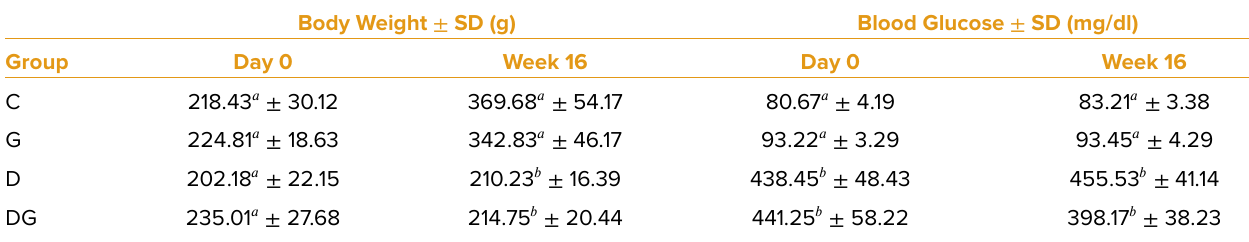
Table 1. Body weight and serum glucose levels in the experimental groups (Day 0 = Day of diabetes induction).